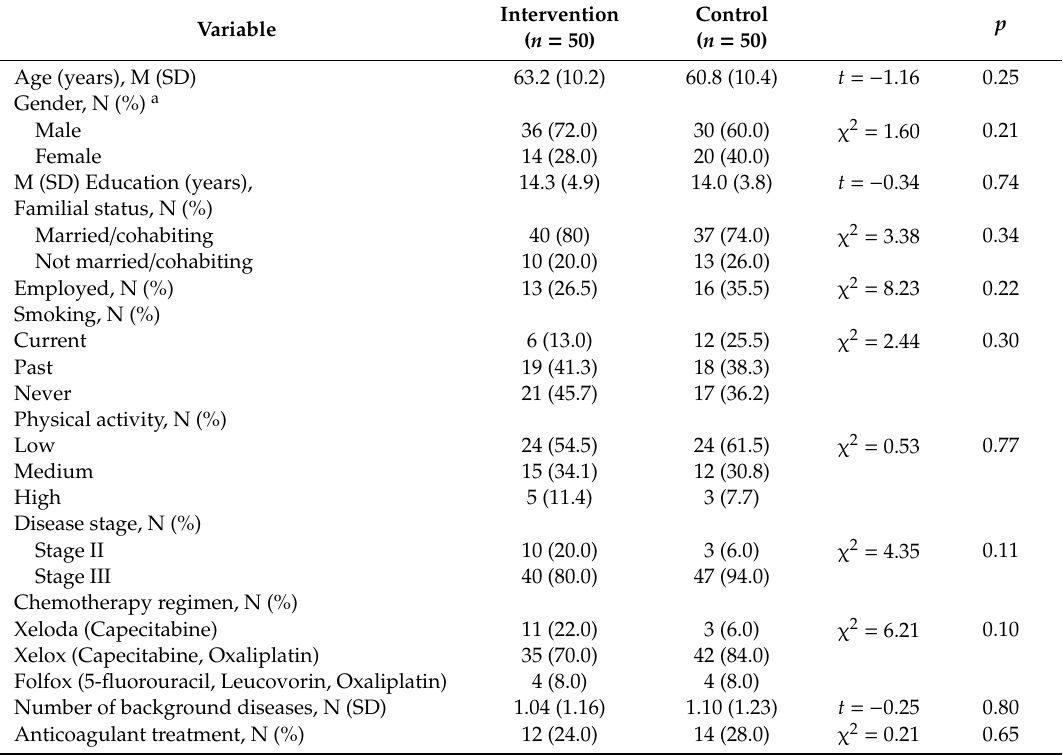
Table 1. Background characteristics of the participants by